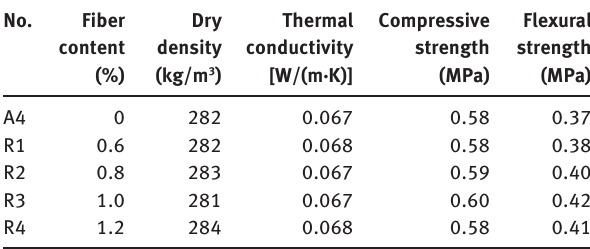
Table 3 Effect of different contents of untreated glass fiber on the performance of samples.